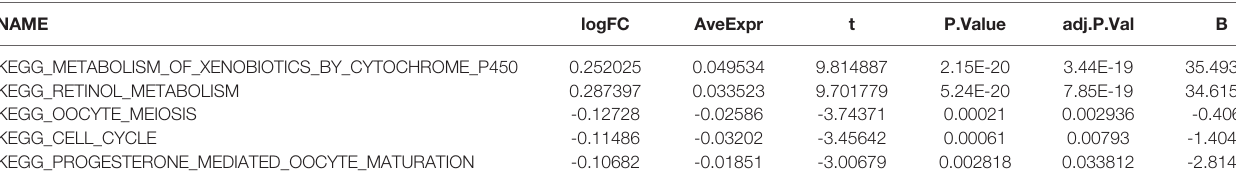
TABLE 4 | Gene Set Variation Analysis between high- and low risk groups in the TCGA cohort.